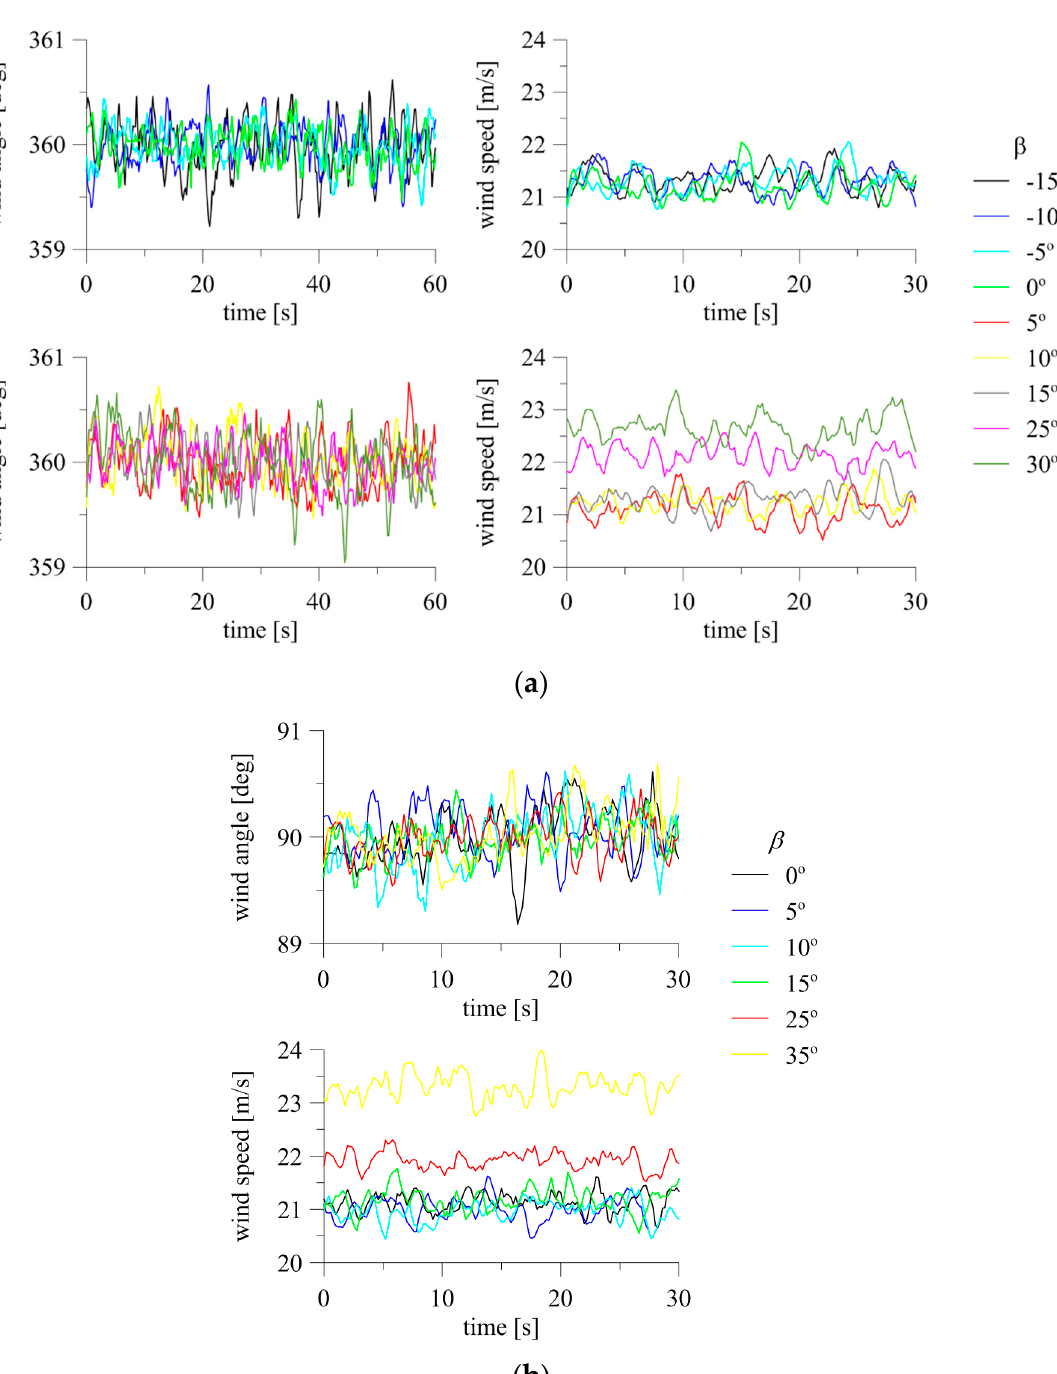
Figure 11. Fluctuations of wind angle and speed at changing β for 2D anemometer: ( a ) α = 0 ◦ ; ( b ) α = 90 ◦ . ◦ ◦ ◦ The mean speeds at α = 90 and at β = 0 to + 15 were similar to each other and di ff ered from the initial speed maximally by 0.20 m / s, which is 0.96% of the reference. The di ff erence was still acceptable ◦ ◦ at β = + 25 , and significantly deviated at β = + 35 . The values were 0.73 and 2.16 m / s, which represent 3.44% and 10.20%, respectively. The standard deviations of speed and angle ranged from 0.19–0.22 ◦ ◦ ◦ m / s and 0.20–0.26 . The values were similar at β = 0 to + 25 , and only slightly higher at β = + 35 ◦ for which they were 0.25 m / s and 0.28